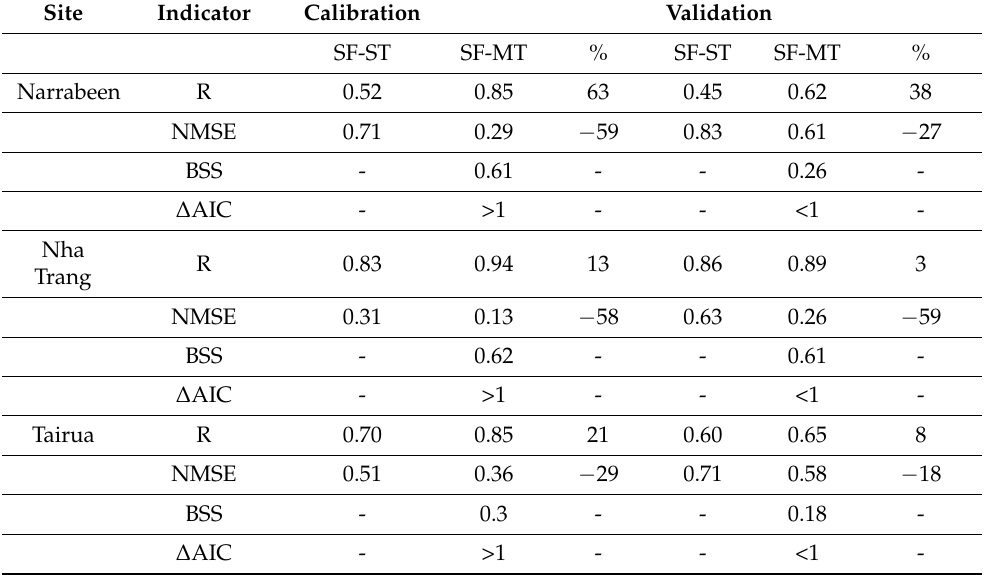
Table 3. Model skill during the calibration and validation phase, for the SF-ST and SF-MT model, at all three sites, using four model skill